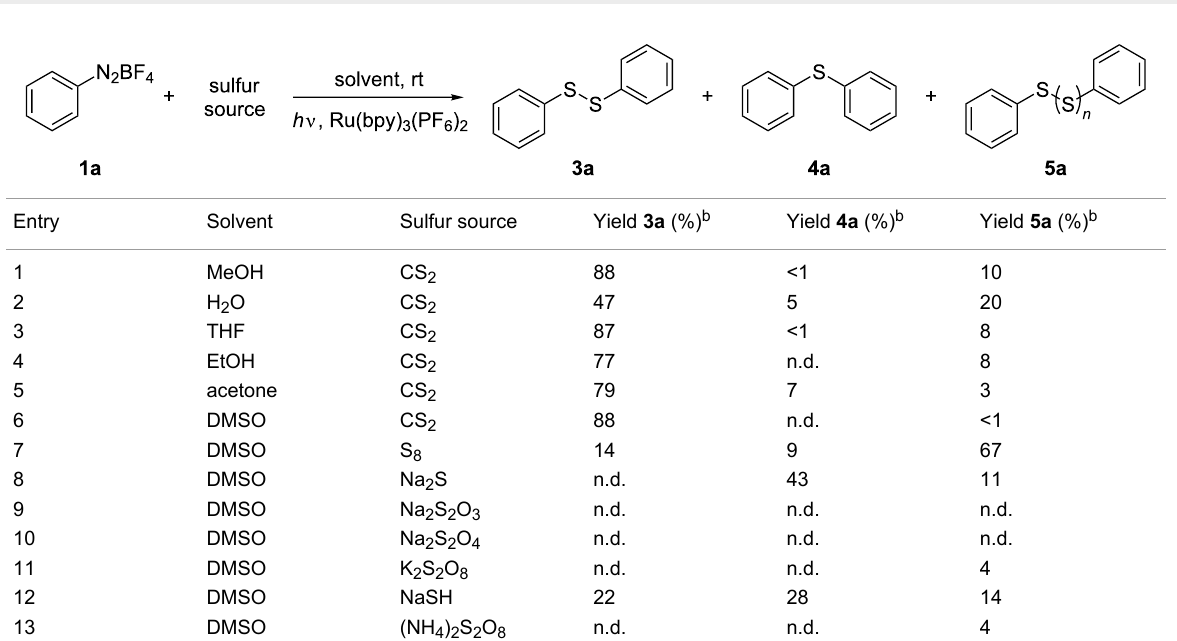
Table 2: Screening of the solvents and sulfur sources for the visible light-mediated coupling of benzenediazonium tetrafluoroborate ( 1a ) and CS 2 ( 2 ) and other sulfur sources in the presence of Ru(bpy) 3 (PF 6 ) 2 as the photocatalyst. a